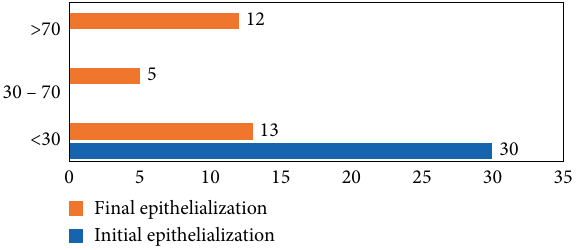
Figure 8: Comparison epithelialization % at start and end of